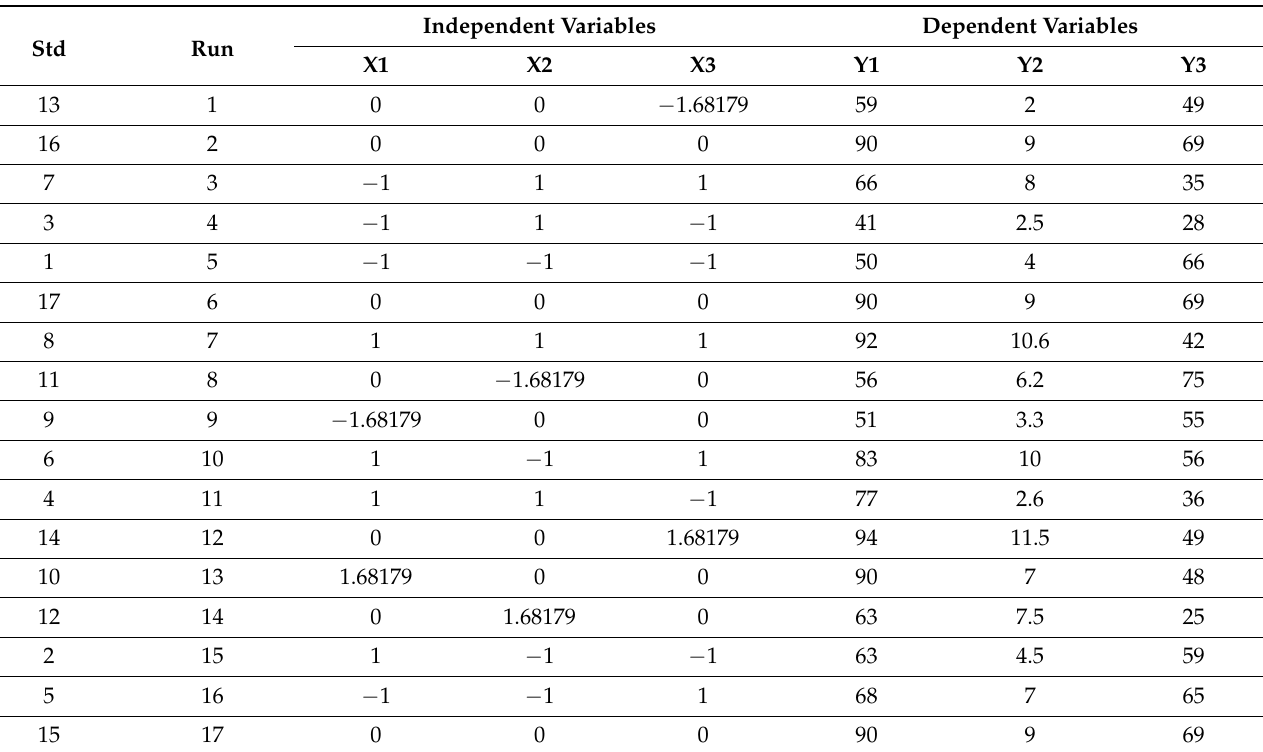
Table 2. The composition of the designed formulations and measured responses of the prepared TEL-loaded oil-entrapped floating alginate beads according to central composite